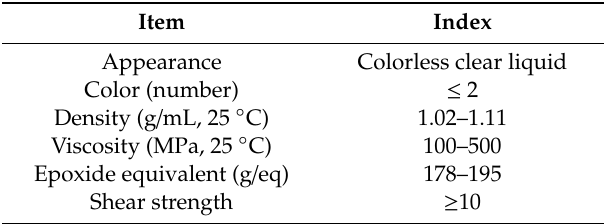
Table 1. Epoxy resin technical index.